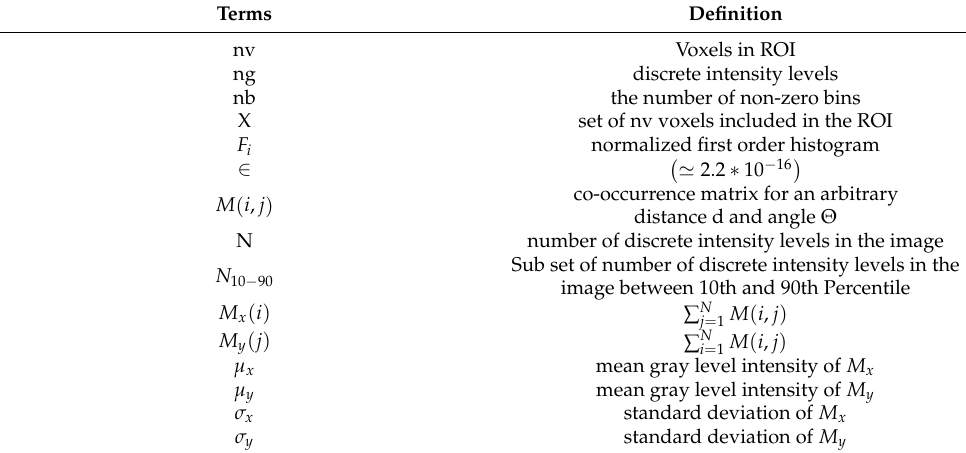
Table A2. Terms used in Radiomic Feature extraction Algorithms.